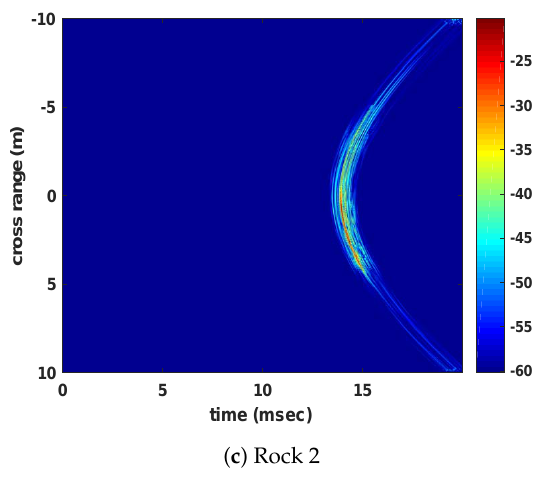
Figure 14. 2D plots of the matched filtered backscattering time series of the three objects at the orientation of 0 degrees (broadside). The dB scale is relative to the brightest pixel in each measurement group. The red lines represent the cross range from − 2.5 to 2.5 m, where 400 time series are